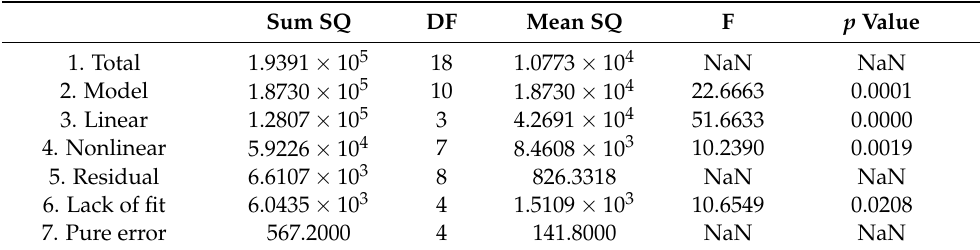
Table A3. ANOVA table of the linear